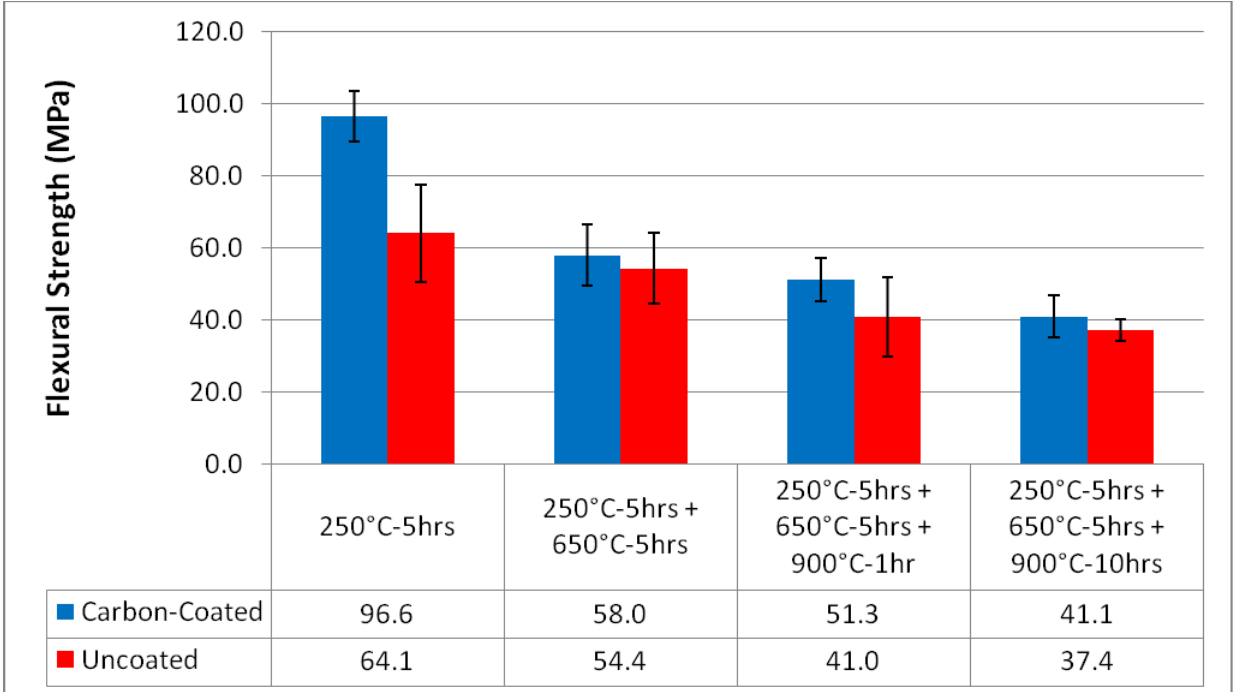
Figure 6. Mean Flexural Strength versus Heat Treatment and Interface Modification (error bars indicate ±1 standard